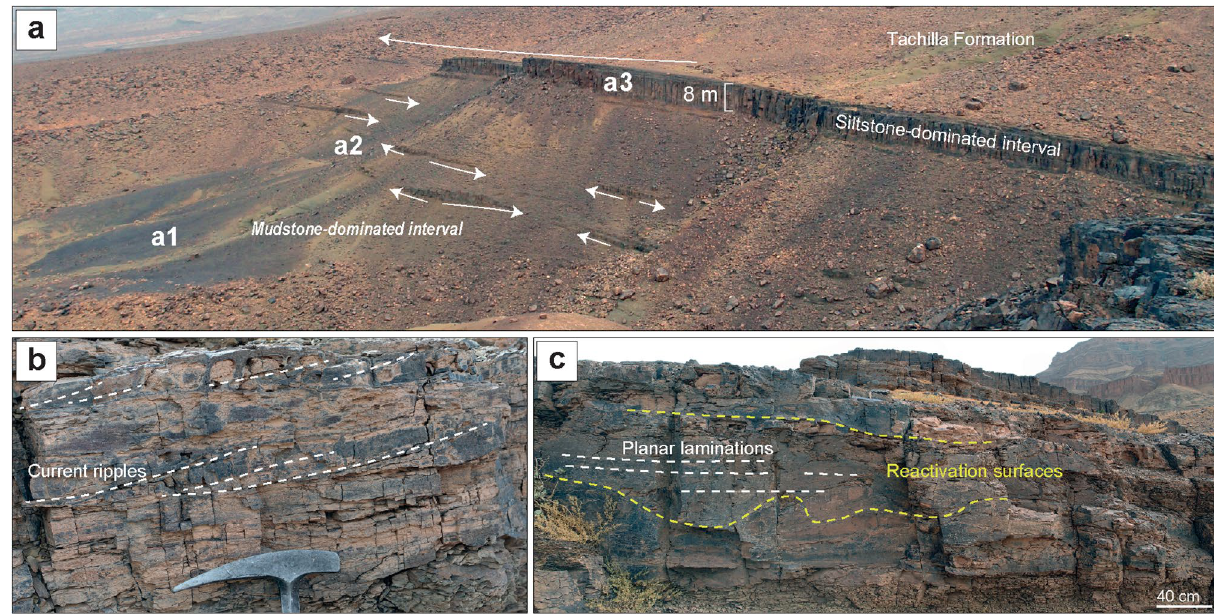
Figure 5. Sedimentary context of Taichoute. ( a ) Overview of the upper part of the Fezouata Shale displaying a transition between a1, a2, and a3. The large siltstone-lobes of a3 transition upward into the overlying Middle Ordovician Tachilla Formation. The white arrows show the lateral discontinuity, characteristic of the siltstone lobes. ( b ) The asymmetrical cross-laminations form current ripples displayed in the siltstone lobes. ( c ) Reactivation surfaces occur frequently in the siltstone lobes, attesting to the turbulence of repeated density flows. These deposits also display planar laminations.